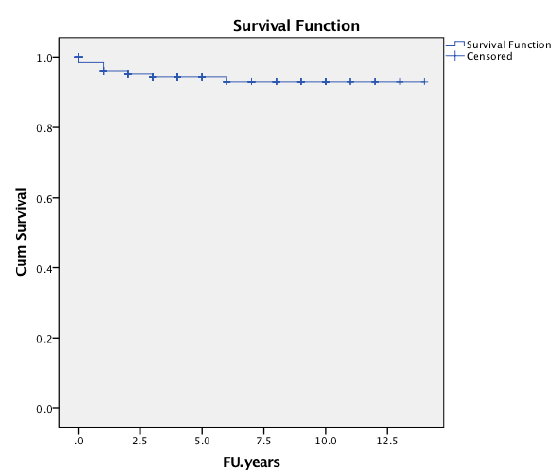
Figure 6. Kaplan-Meier implant survival curve with the endpoint of stem revision for any reason at the observed period.